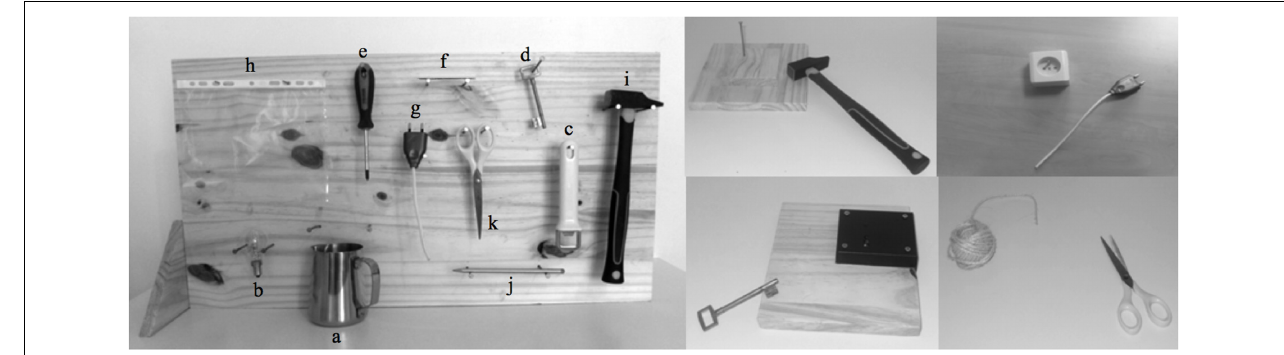
FIGURE 1 | The real tool use test. The left picture represents the vertical “tool panel” used for the presentation of the tools (a, jug; b, light bulb; c, bottle cap opener; d, key; e, screwdriver; f, piece of chalk; g, electrical plug; h, plastic sleeve; i, hammer; j, lead pencil; k, scissors). The right picture show examples of tools and the corresponding objects upon which they can be used (i.e., glass, desk lamp, capped glass bottle, lock on a wooden board, screw in a wooden board, slate, electrical socket, ringbinder, nail in a wooden board, pencil sharpener, coil of hemp yarn, respectively).